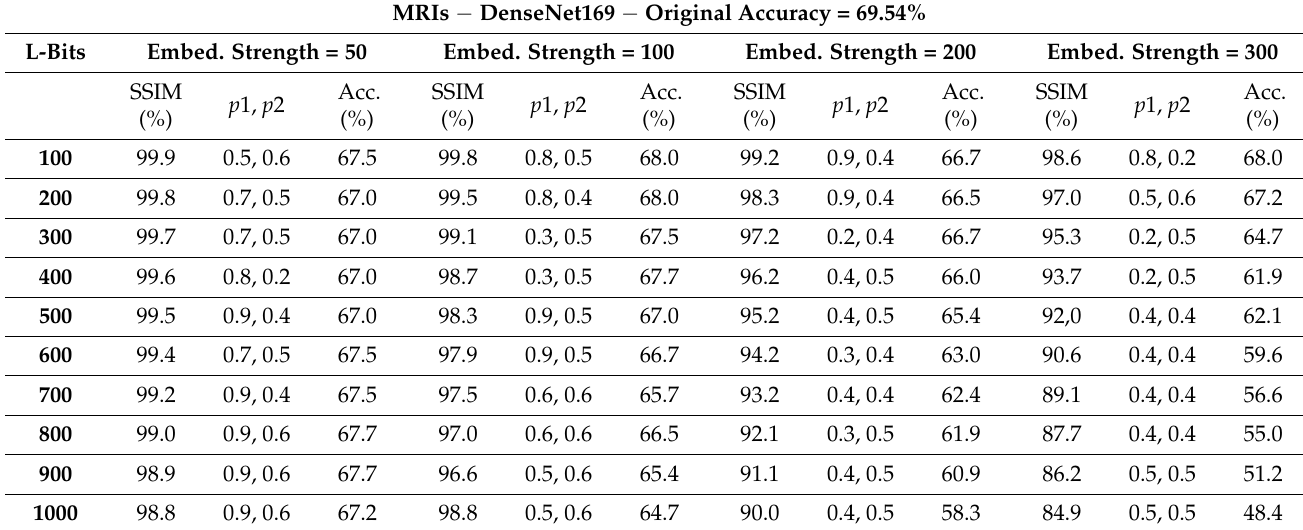
Table A3. KMsWA 2 attacks on DenseNet169 in MRIs.